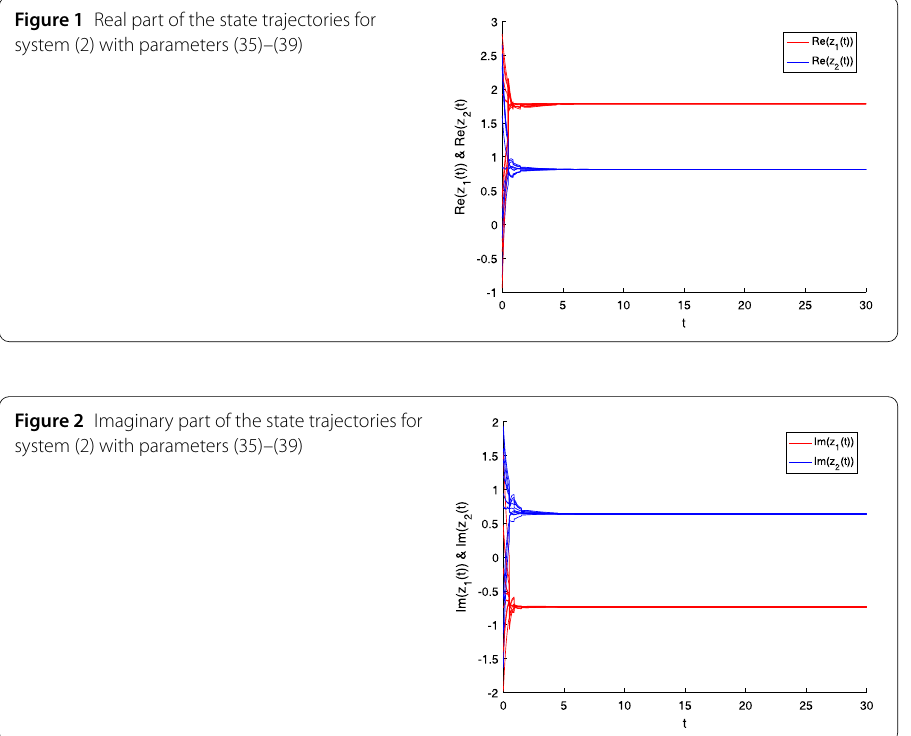
Figure 1 Real part of the state trajectories for system (2) with parameters (35)–(39)